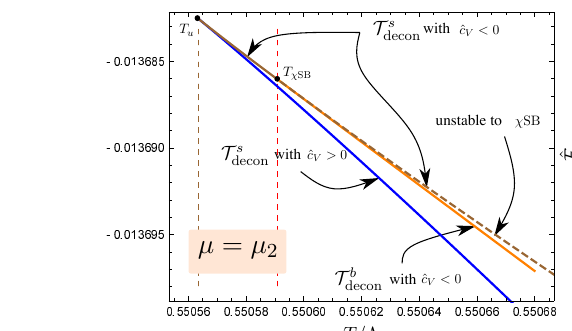
Figure 29 . Typical phase diagram in the canonical ensemble for deconfined states Klebanov-Tseytlin black holes) and (see (6.15)) (the left panel), and for µ = µ 2 > µ ⋆ (the right